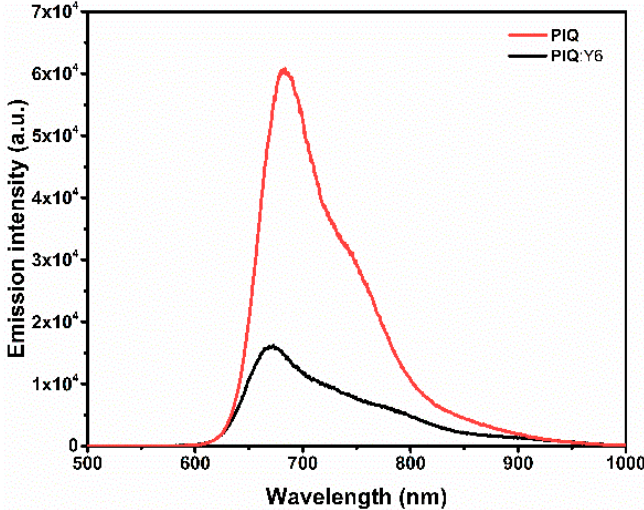
Figure 5. Thin-film photoluminescence spectra of PIQ and PIQ :Y6 blend.